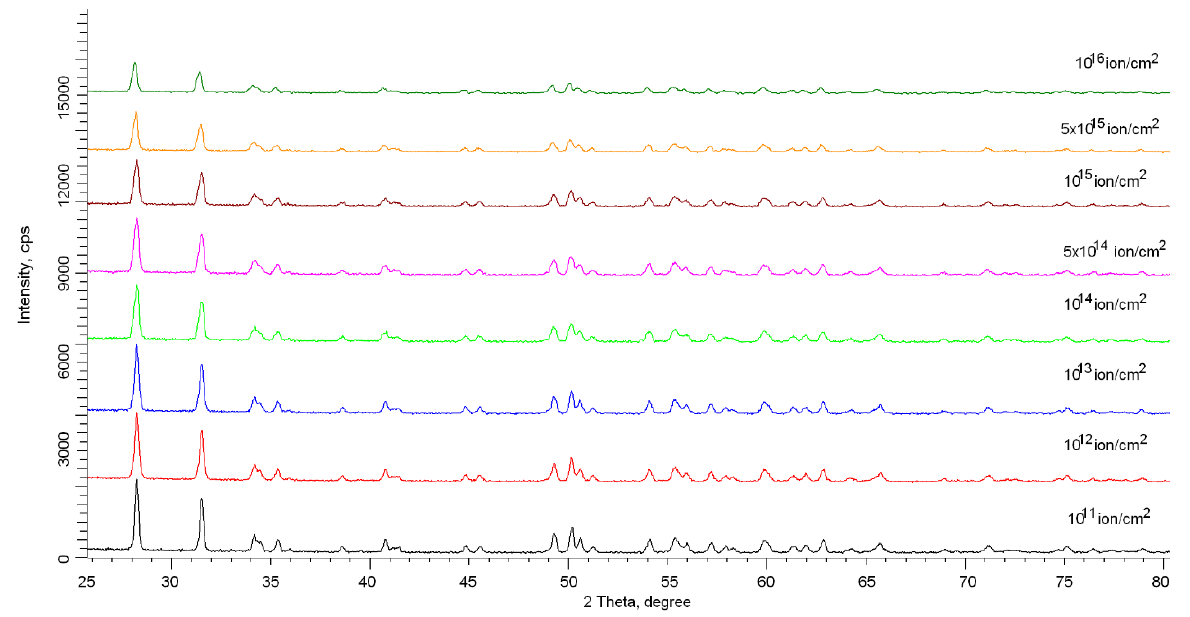
Figure 3. X-ray diffraction patterns of the studied ceramics depending on irradiation fluence.